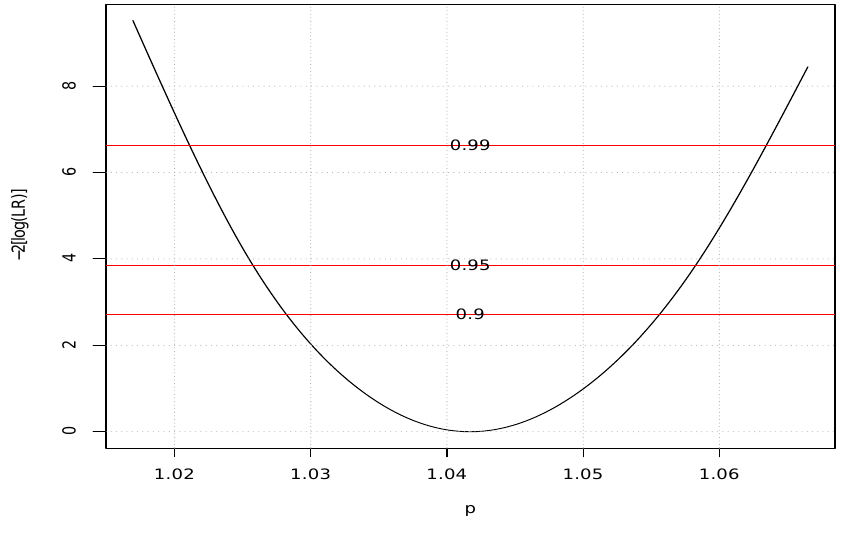
Figure 8. Profile likelihood for p in Northern